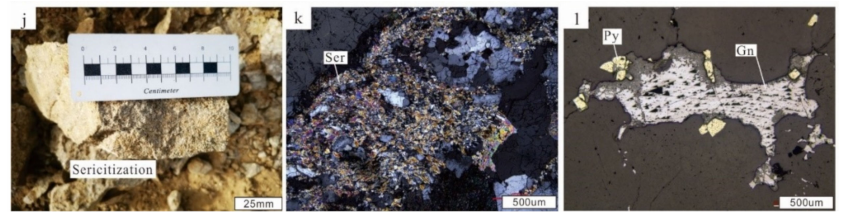
Figure 4. Representative photos and photomicrographs of the Juyuan ore deposit. ( a ) Distribution characteristics of the granite, quartz porphyry, and quartz vein in Juyuan mining area; ( b ) Late- stage quartz veinlets in monzogranite; ( c ) Early-stage quartz veins; ( d ) Intermediate ore-bearing hydrothermal quartz veins; ( e ) Wolframite in quartz vein; ( f ) Scheelite ore fluorescent under a tungsten lamp; ( g ) Microscopic characteristics of monzogranite; ( h ) Microscopic characteristics of wolframite; ( i ) The interspersed relationship between wolframite and scheelite under microscope; ( j ) Sericitized hand specimen; ( k ) Microscopic characteristics of Sericitized; ( l ) Galena and pyrite in the intermediate-stage of